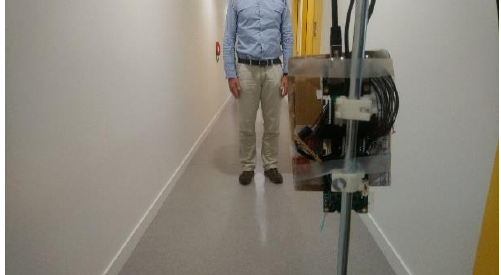
Figure 14. Experiment setup: the preliminary INSPEX prototype is fixed on a white cane; the device tries to detect obstacles (walls, objects, people) in a corridor. Sensors 2019 , 19 , x FOR PEER REVIEW